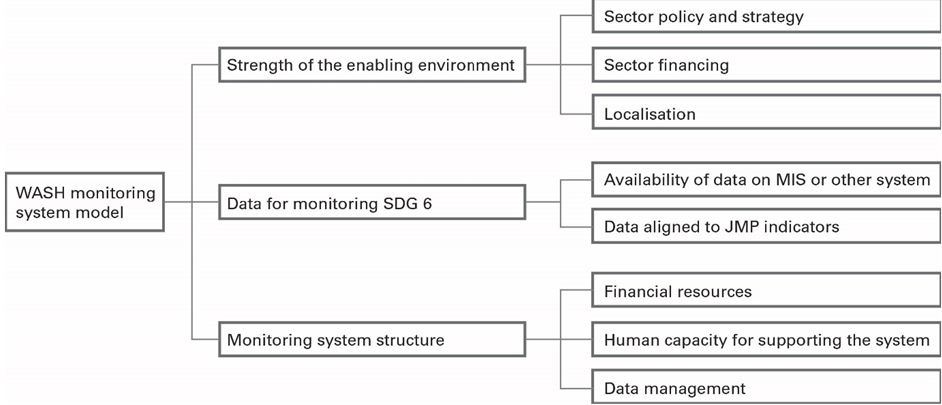
Figure 2. WASH monitoring system hierarchy model.